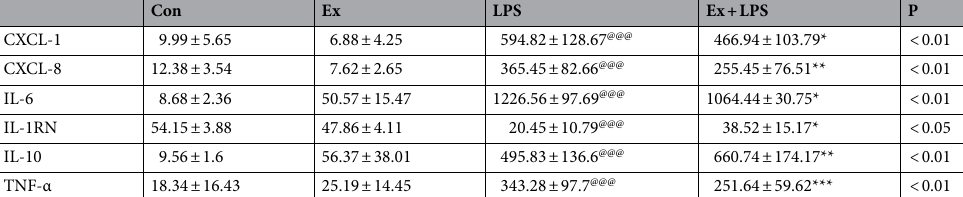
Table 2. Cytokine levels in BALF (pg/mL). The levels of CXCL-1, CXCL-8, IL-6, IL-1RN, IL-10, and TNF-α in BALF were detected. @@@ P < 0.05, Con versus LPS groups. * P < 0.05, LPS versus Ex + LPS groups. ** P < 0.01,